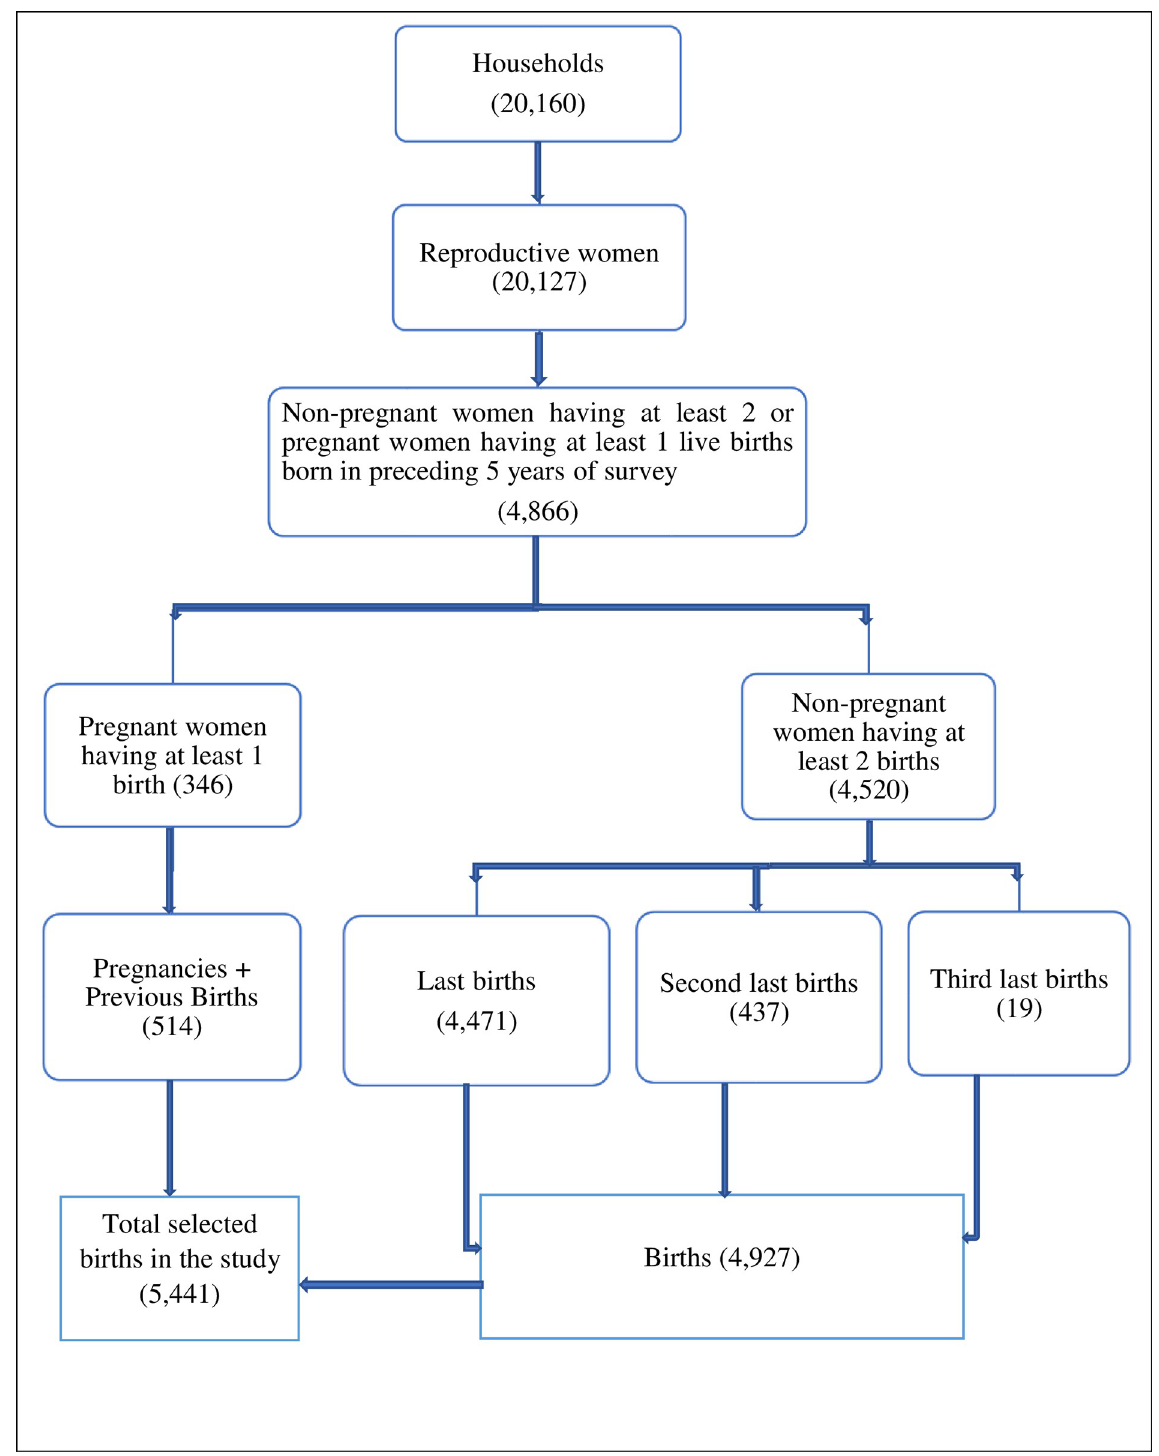
Fig 1. Flow chart to select live births in computing birth intervals.